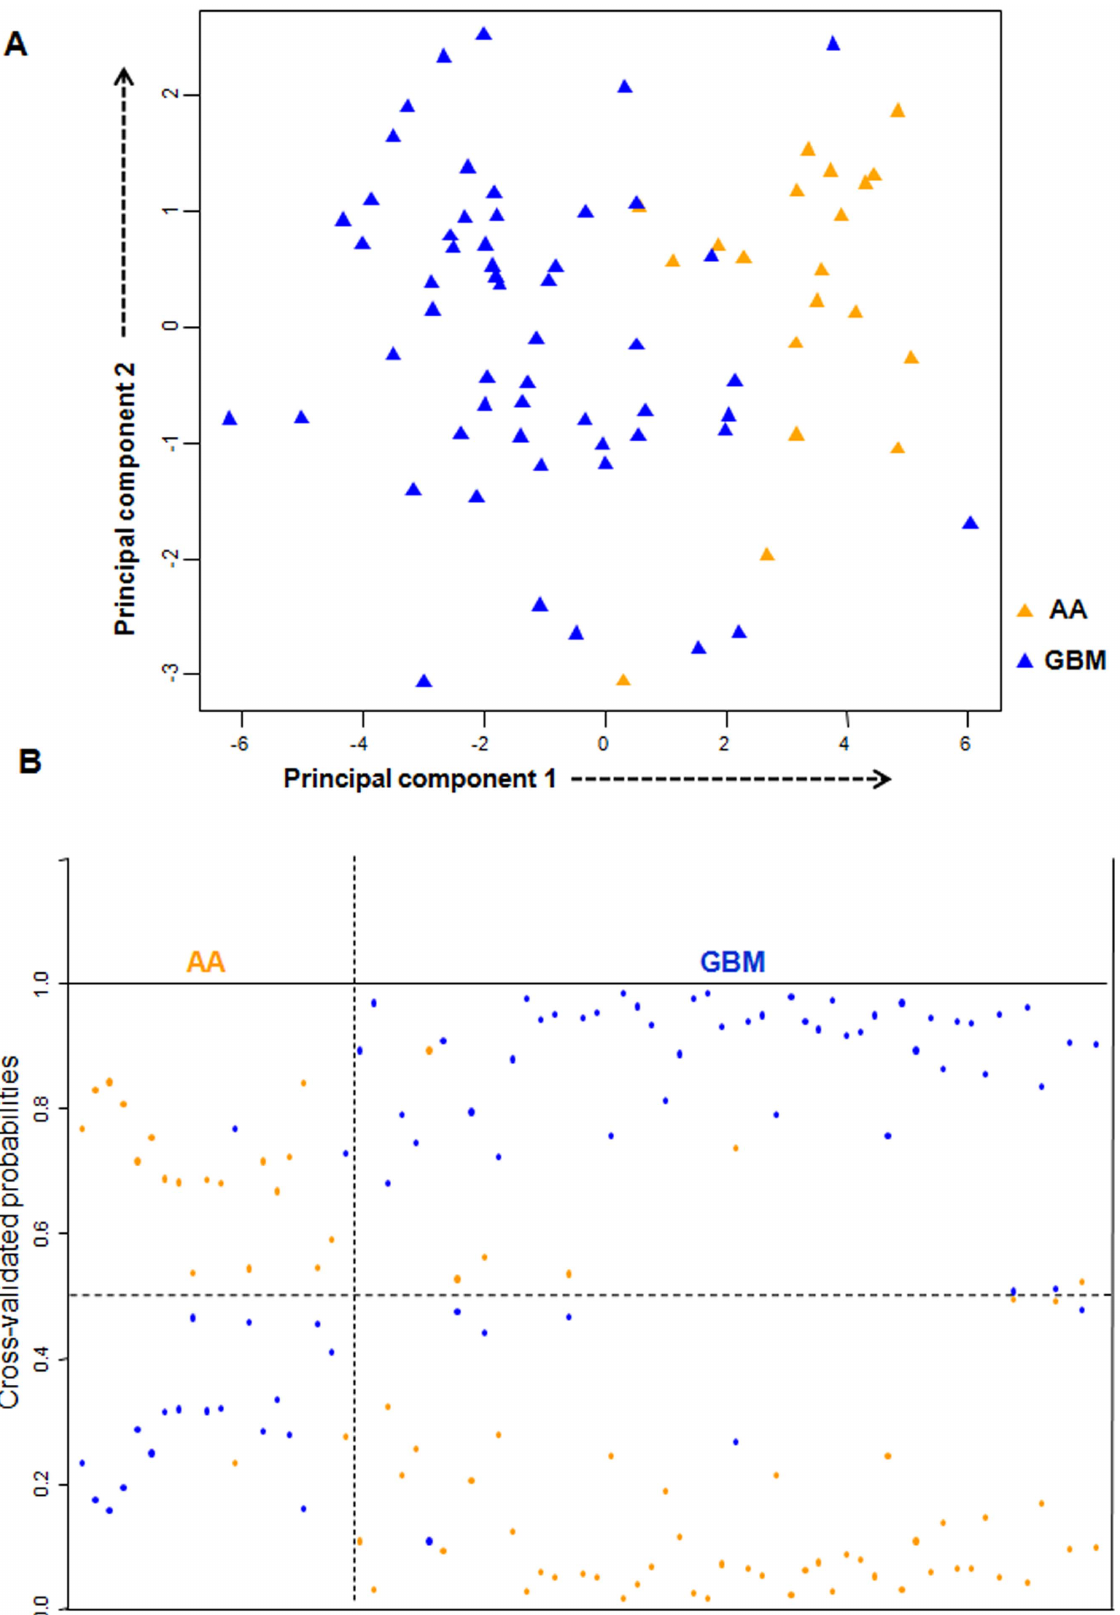
Figure 4. PCA and cross validated probabilities of AA and GBM samples of test set. A. PCA was performed using expression values of 16-